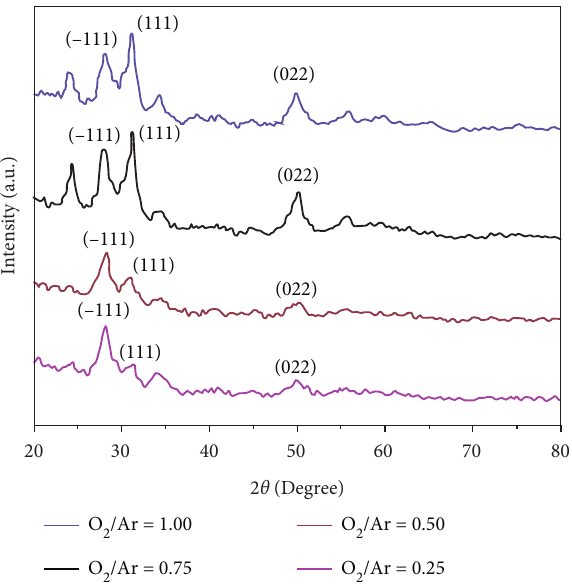
Figure 2: XRD outline of prepared ZrO